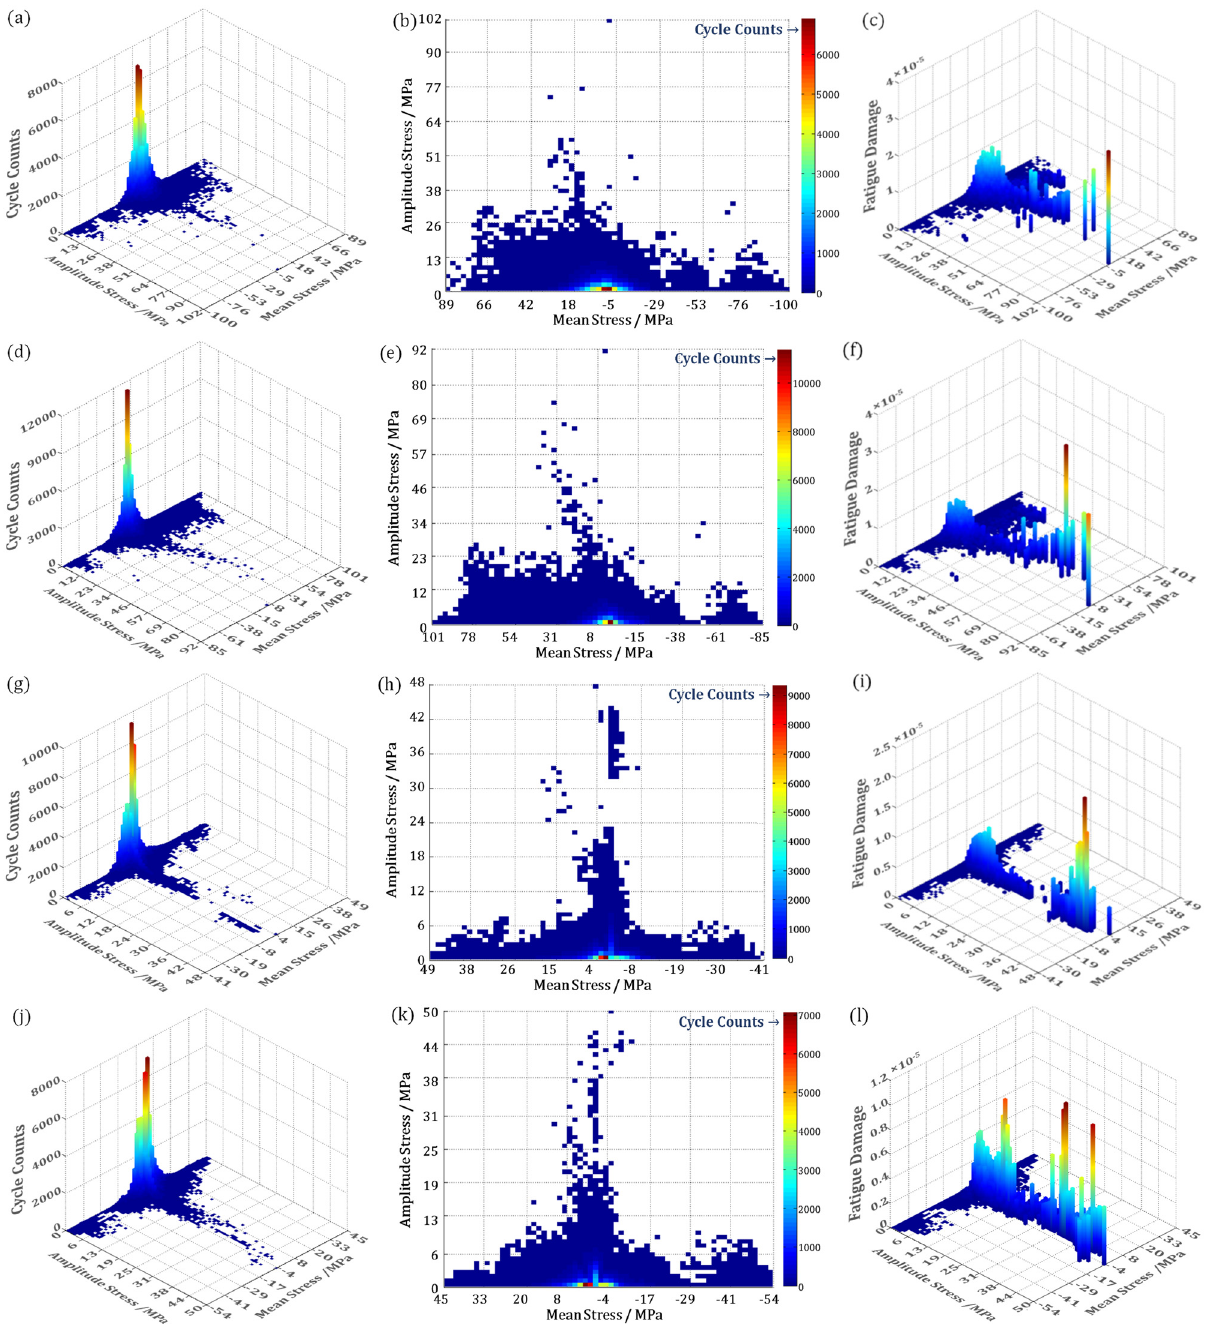
Figure 20: Contour map of 64 - grade load and damage spectra at weak locations: ( a ) load spectra at WB1#; ( b ) bottom view of load spectra at WB1#; ( c ) damage spectra at WB1#; ( d ) load spectra at WB2#; ( e ) Bottom view of load spectra at WB2#; ( f ) damage spectra at WB2#; ( g ) load spectra at JR1#; ( h ) bottom view of load spectra at JR1#; ( i ) damage spectra at JR1#; ( j ) load spectra at JR2#; ( k ) bottom view of load spectra at JR2# and ( l ) damage spectra at